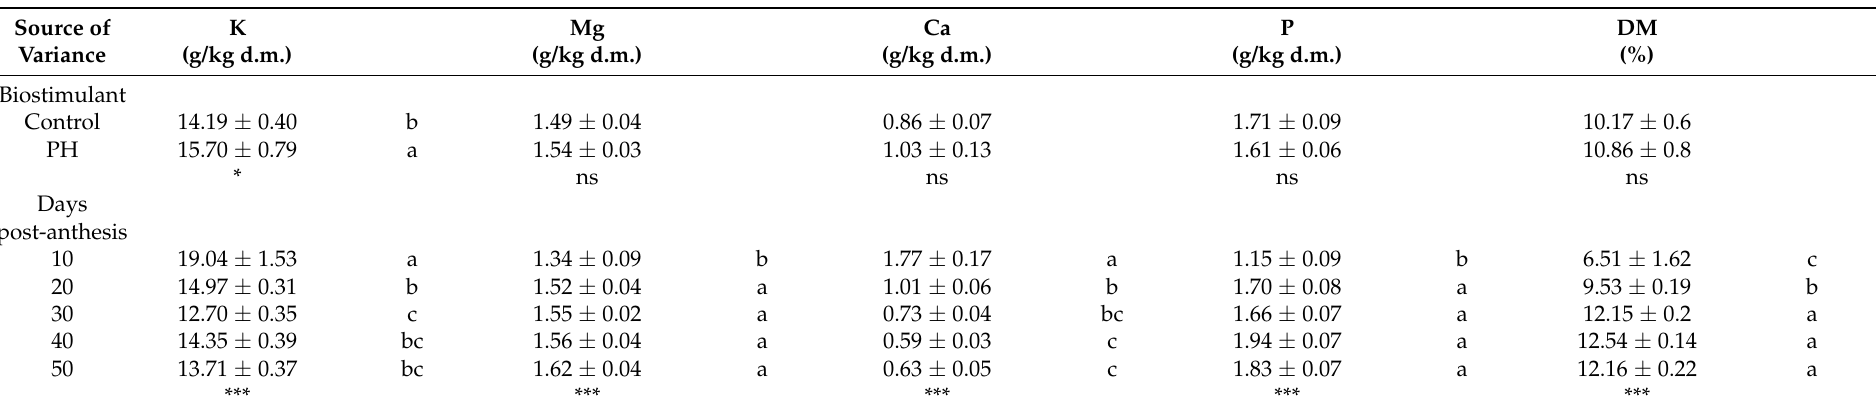
Table 4. Mean comparisons for fruit content in K, Mg, Ca, P, and dry matter (DM) obtained from watermelon cv. Obla harvested at 10, 20, 30, 40, and 50 days post-anthesis with (PH) or without (Control) protein hydrolysate biostimulant application. Source of K Variance (g/kg d.m.)